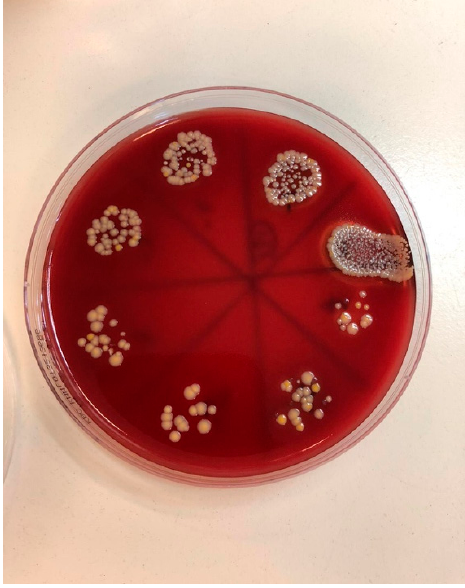
Figure 7. Pour plate technique, performed on blood agar after an incubation period of 48 h. One randomly chosen sample from each group was subjected to SEM to assess the reduction in bacterial and fungal cell growth (Figures 8–11).